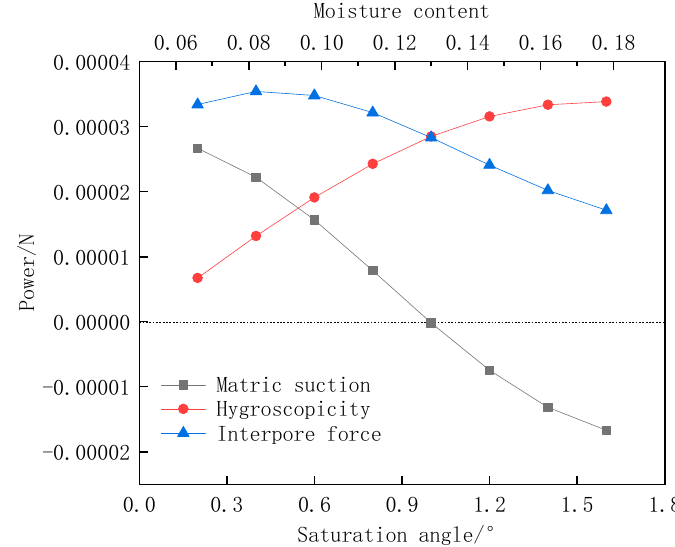
Figure 5. Relationship between pore stress and water content.